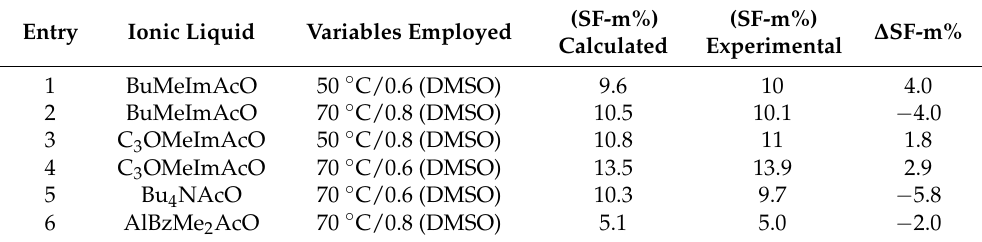
Table 4. Comparison of calculated and experimental values under conditions different from those employed to generate the mathematical